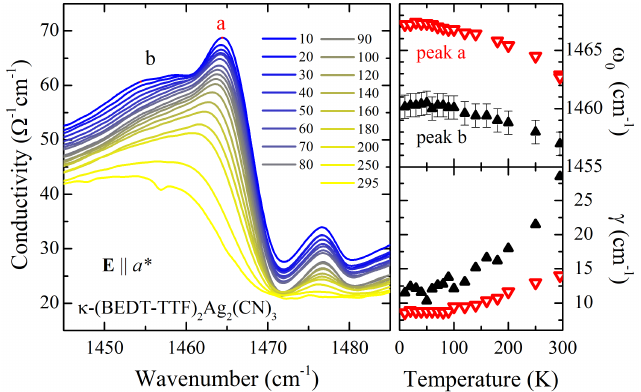
Figure 10. ( Left ) Temperature evolution of the intramolecular vibration ν 27 of κ -CuCN. ( Right ) Temperature dependence of the resonance frequency and damping obtained by Fano function fit of the mode.